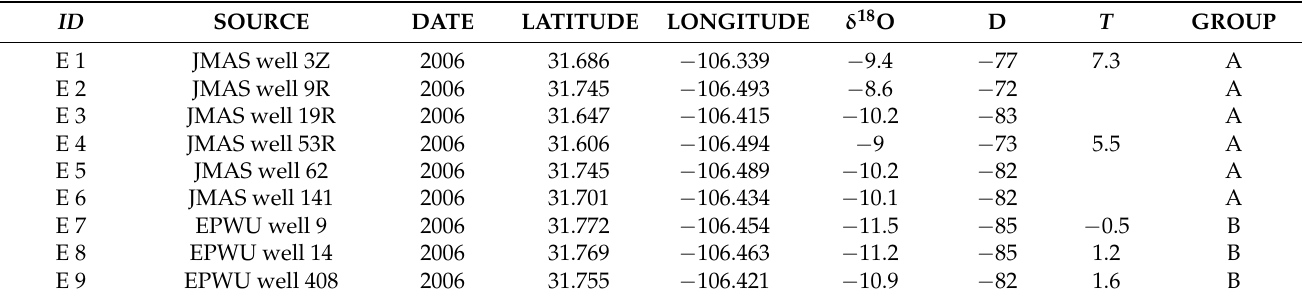
Table A1. Data used for this